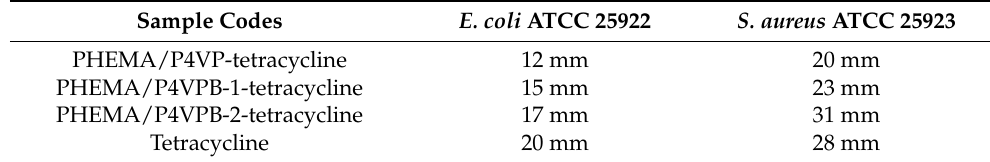
Table 4. Diameters of inhibition